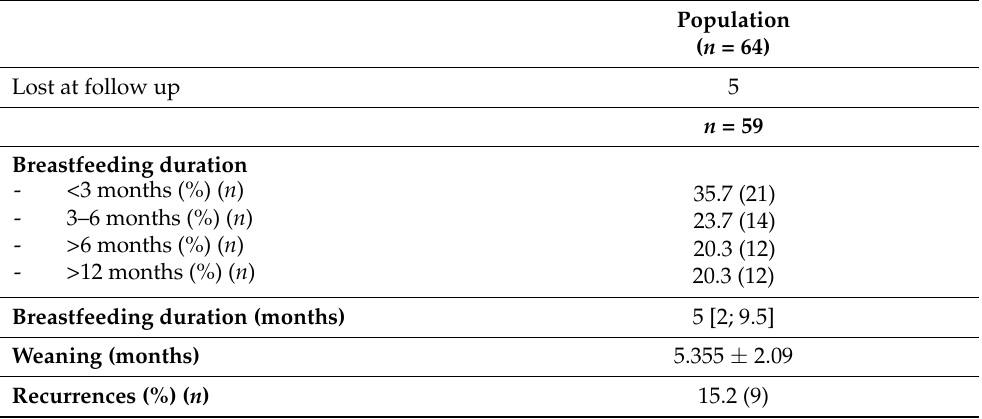
Table 4. Follow up—breastfeeding duration.